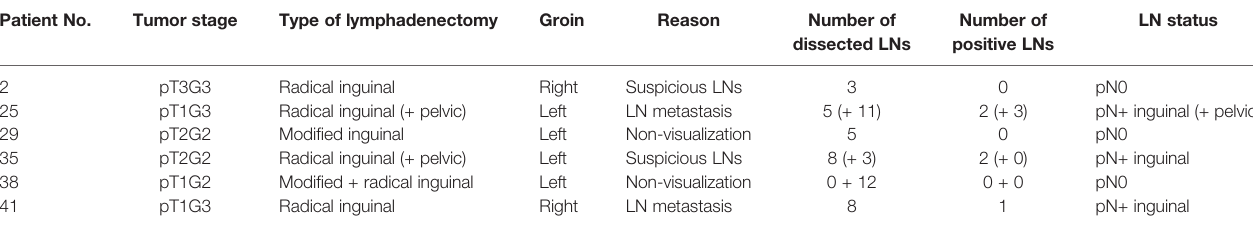
TABLE 3 | Histopathological results of unilateral modi fi ed or radical inguinal lymphadenectomy in six patients. Patient